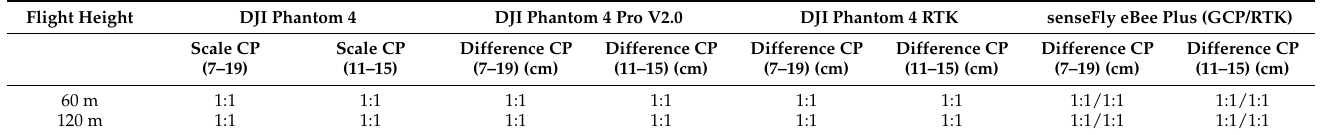
Table 10. Calculated map scales.